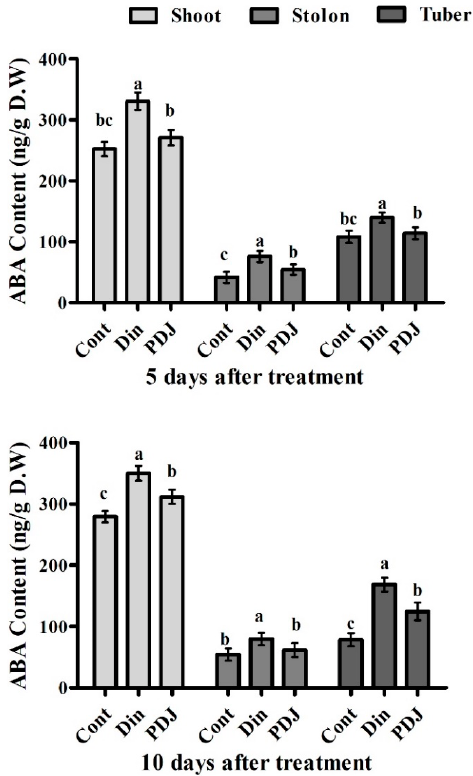
Fig. 5: Abscisic acid contents of shoot per each treatment (Cont; Control, Din; Diniconazole, PDJ; Prohydrojasmon). The differences between the mean values were determined using a DMRT at P < 0.05. The re- sults were graphically presented using GraphPad Prism (version 5.0, San Diego, CA, USA). The SAS 9.1 was used for DMRT analysis.